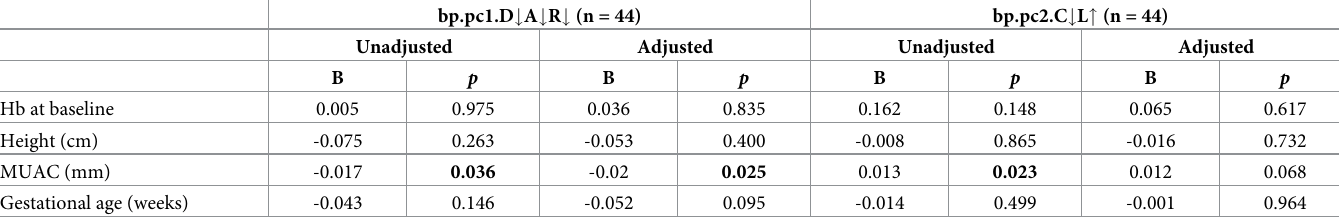
Table 4. Associations of maternal baseline nutrition characteristics with maternal baseline pregnancy